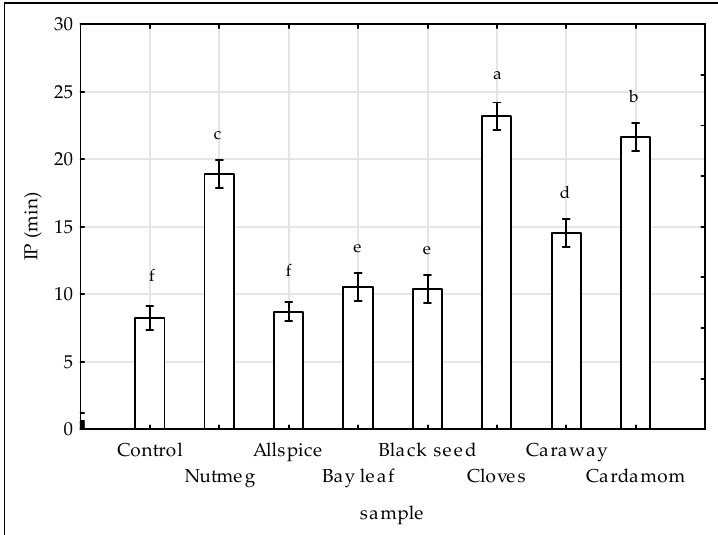
Figure 3. Effect of various spice extract treatments on the oxidation induction period (IP) determined by DSC. Means with the various superscript within the same day are significantly different ( p ≤ 0.05, Duncan’s test). Vertical bars indicate 0.95 confidence intervals.